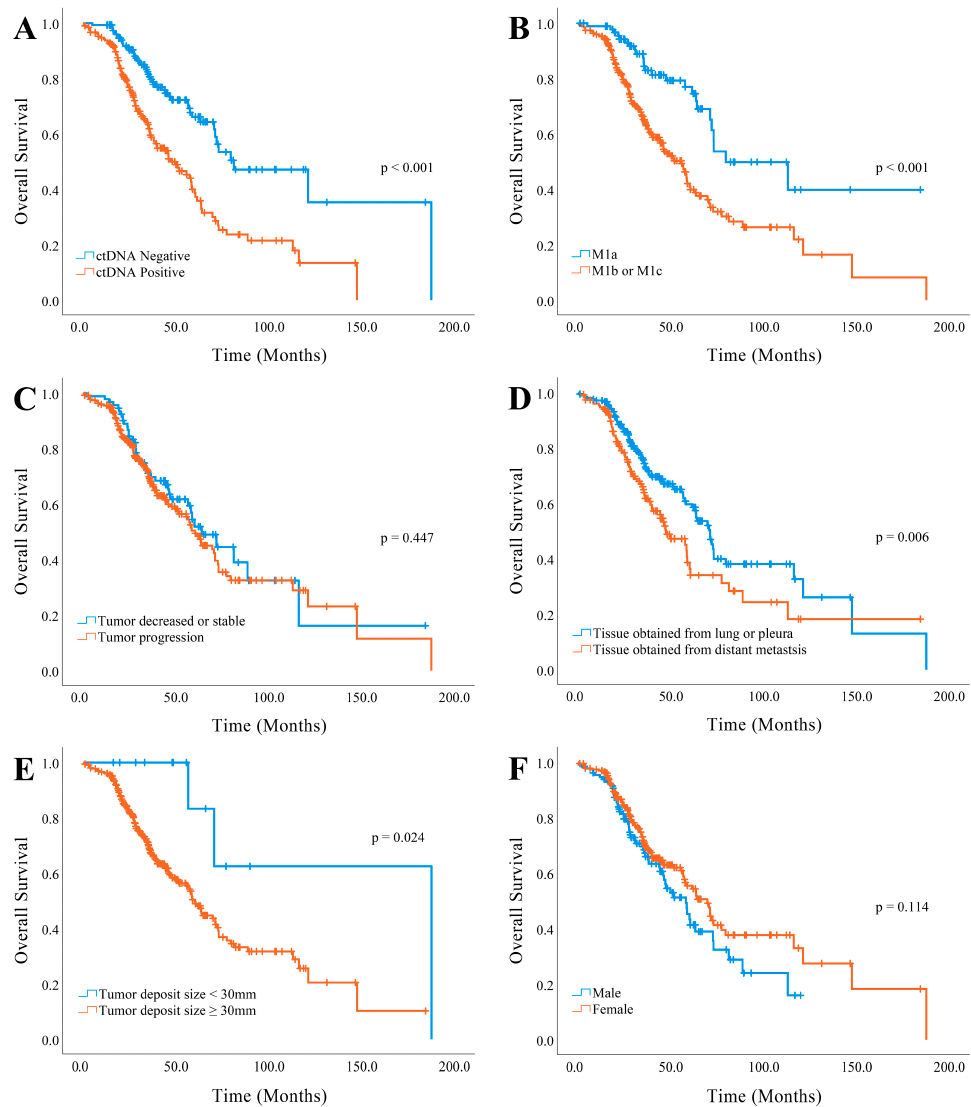
Figure 4. Kaplan–Meier curves for overall survival. The ctDNA status ( A ), advanced M stage above M1a ( B ), the site of tumor tissue obtained for EGFR analysis ( D ), and the larger size of the largest tumor deposits more than 30 mm ( E ) were significantly correlated with overall survival. The disease progression ( C ) and sex ( F ) failed to reveal a correlation with overall survival.